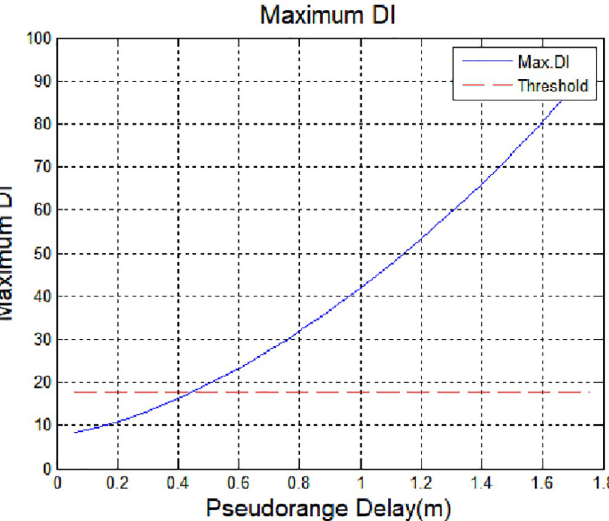
Fig 11. Maximum detection index according to spoofing